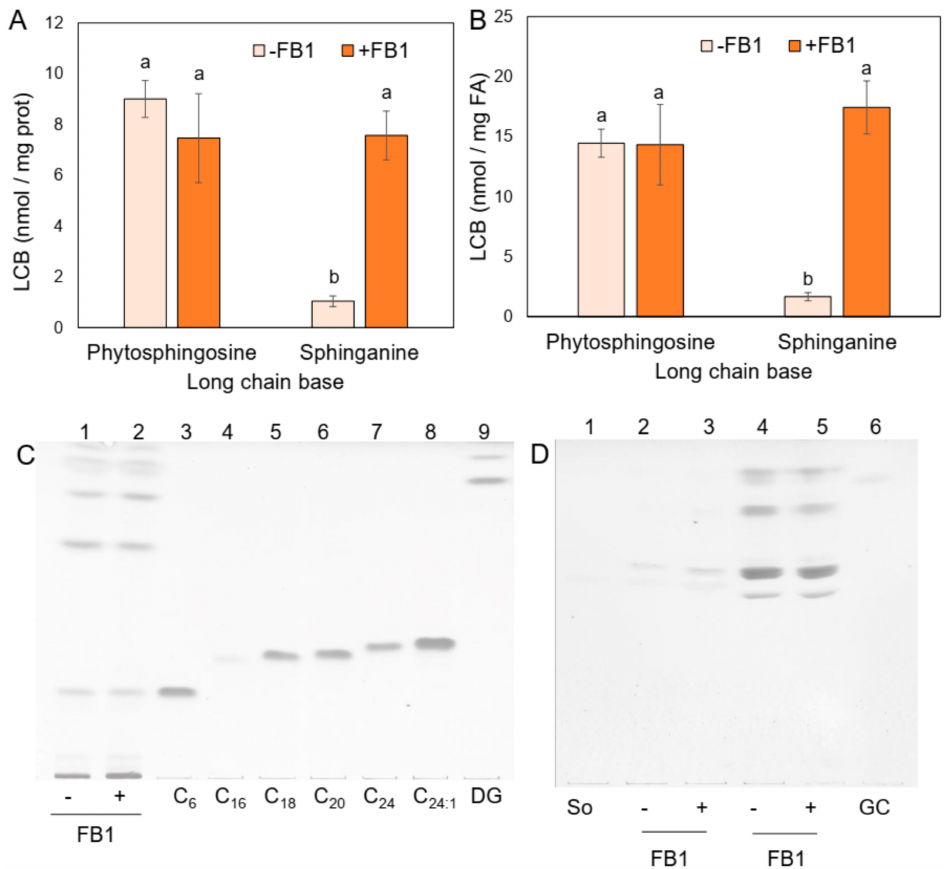
Figure 2. Levels of long chain bases (LCBs), ceramides, and glucosylceramide in PM from maize embryos exposed to FB1. Maize embryos were exposed to 10 µ M FB1 for 24 h and PM fractions were isolated, lipid extracts obtained and LCBs, ceramides and glucosylceramide determined. ( A ) LCBs determined are expressed in terms of nmol / min / mg protein. ( B ) LCBs determined were expressed in terms of nmol / min / mg fatty acid. Data are the means ± SD of six independent experiments with at least three di ff erent membrane preparations. Holm–Sidak t -test was performed using GraphPad Prism version 8.0 for Windows, GraphPad Software (San Diego, CA, USA). ( C ) Ceramides were determined in extracts containing the equivalent to 18 µ g of PM protein and then separated in thin layer chromatography (TLC) plates eluted with a mobile phase of CHCl 3 :CH 3 OH:CH 3 COOH, 94:1:5 v:v:v and developed with a copper solution. Lanes 1 and 2 were loaded with 18 µ g of PM extract from control and 10 µ M FB1-imbibed embryos. Lanes 3–8 contained 20 nmol of the indicated ceramides and lane 9 contained 20 nmol of a diglyceride (DG) with C18:0 and C20:0 fatty acids. ( D ) Glucosylceramides were detected in extracts containing the equivalent to 18–36 µ g of PM protein and then separated in TLC plates eluted with a mobile phase of CHCl 3 :CH 3 OH:CaCl 2 0.22 %, 60:35:8 v:v:v and developed with a copper solution. Lane 1 contained 10 nmol of sphingosine, lanes 2 and 3 were loaded with 18 µ g of PM extract from control and 10 µ M FB1-imbibed embryos, lanes 4 and 5 were loaded with 36 µ g of the same extracts and lane 6 contained 20 nmol of glucosylceramide. Data are representative of at least four independent experiments with at least three di ff erent membrane preparations. DG: Diglyceride with C18:0 and C20:0 fatty acids; C 6 : Ceramide C6:0; C 16 : Ceramide C16:0; C 18 : Ceramide C18:0; C 20 : Ceramide C20:0; C 24 : Ceramide C24:0; C 24:1 : Ceramide C24:1; GC: Glucosylceramide; So: